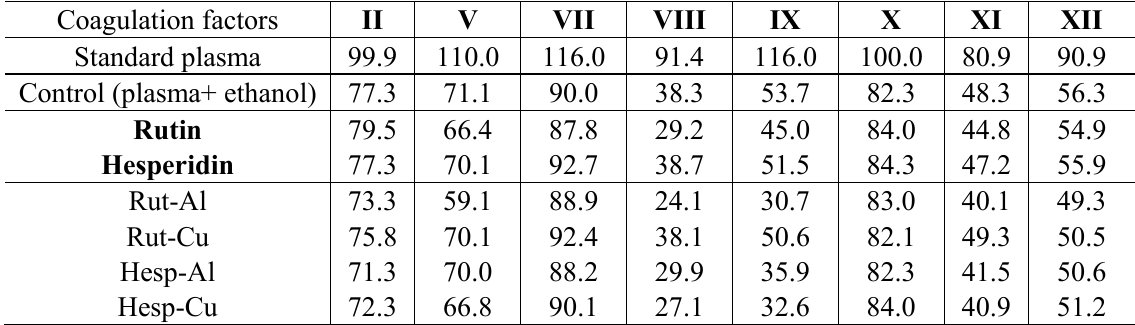
Table 3. The effect of Rut and Hesp and their complexes on the coagulation factors. The values were given in